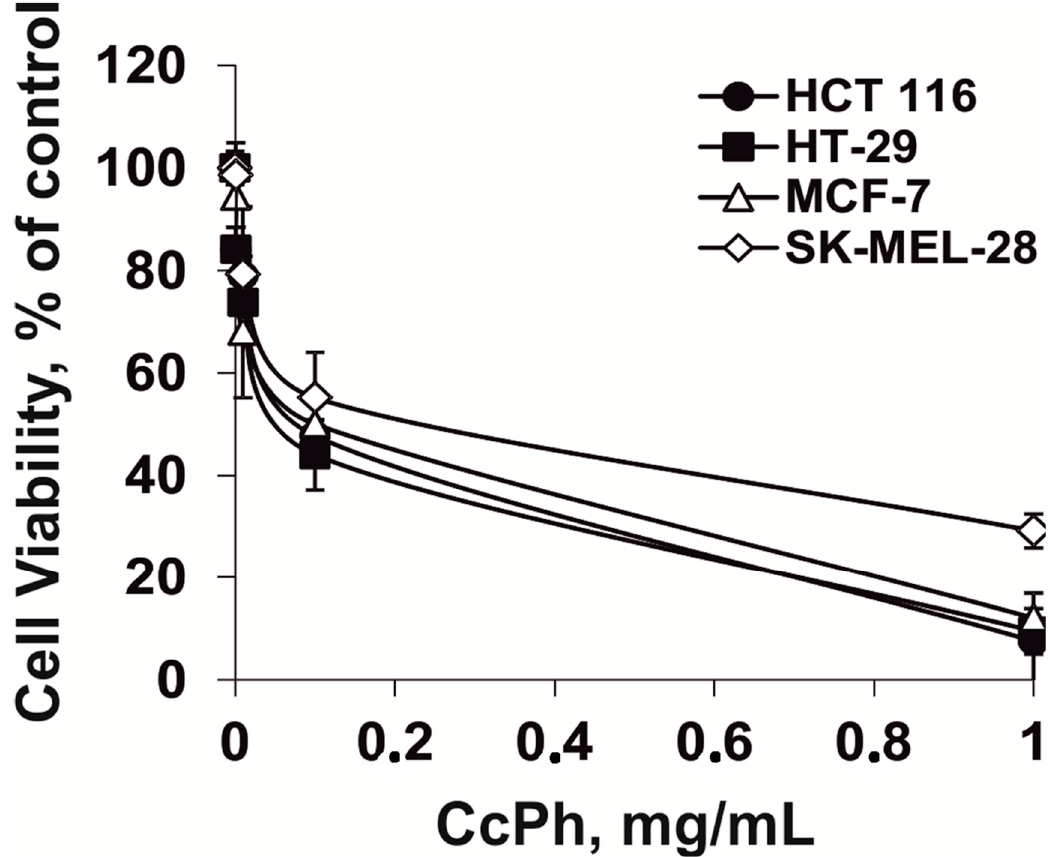
Figure 1. The cytotoxic activity of phlorethols from C. costata ( CcPh ) against colorectal carcinoma HT-29 and HCT 116 cells, breast cancer MCF-7 cells, and melanoma SK-MEL-28 cells. The cells were treated with CcPh at concentration of 0.001–1 mg / mL for 24 h. Cell viability was estimated using the MTS assay. Data are represented as the mean ± standard deviation (SD), as determined from triplicate